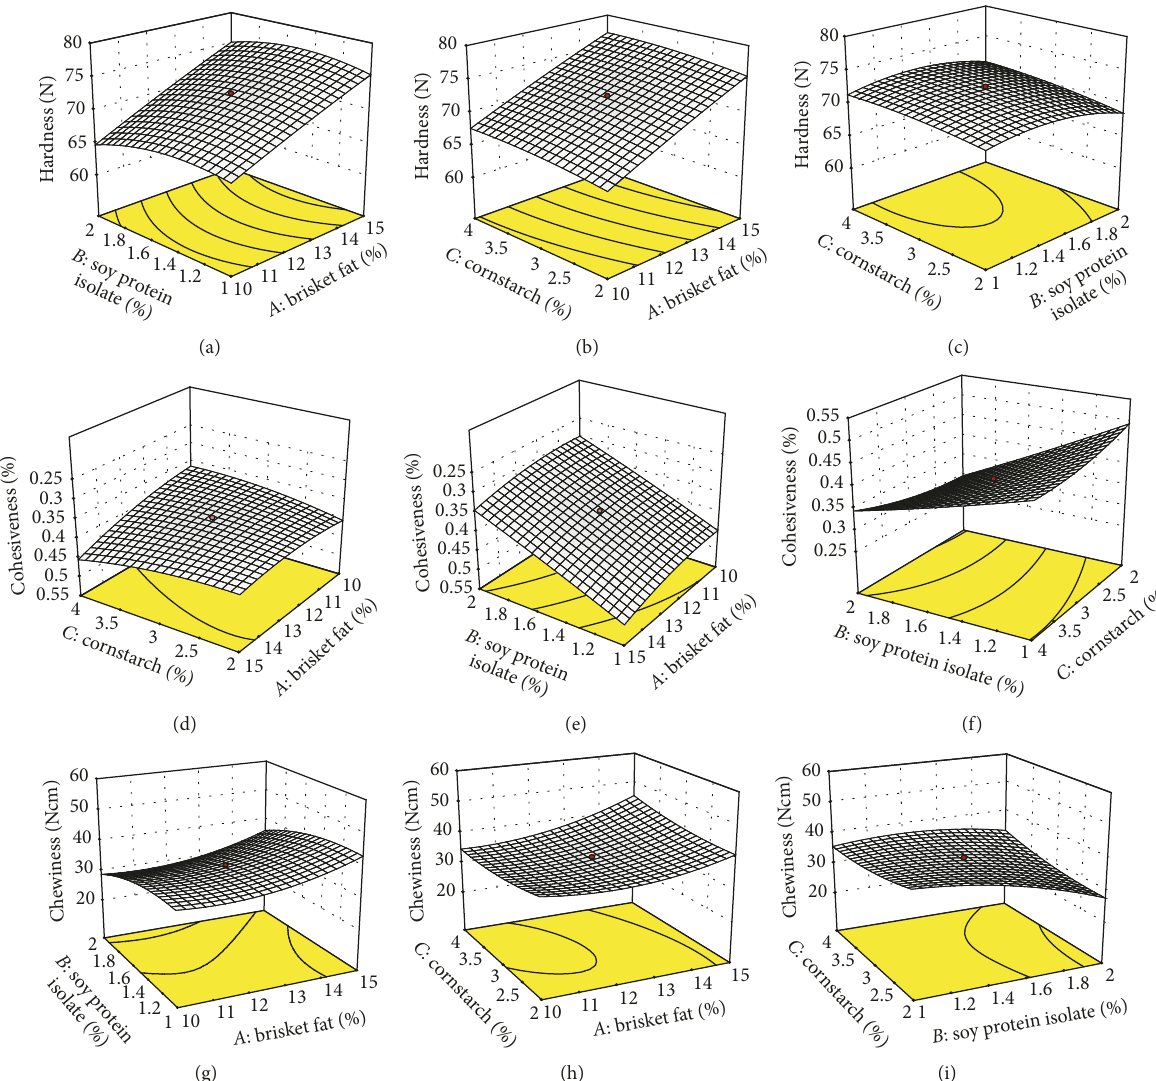
Figure 2: Effect of (a) brisket fat and soy protein isolate, (b) brisket fat and cornstarch, and (c) soy protein isolate and cornstarch on hardness, (d) brisket fat and cornstarch, (e) brisket fat and soy protein isolate, and (f) soy protein isolate and cornstarch on chewiness, and (g) brisket fat and soy protein isolate, (h) brisket fat and cornstarch, and (i) soy protein isolate and cornstarch on cohesiveness along with the second-order polynomial model equations predicting effects of the variables. ((a), (b), (c)) Hardness = 72.22+64.79𝐴−0.53𝐵+0.85𝐶+0.44𝐴𝐵−0.04𝐴𝐶+ 0.27𝐵𝐶 − 0.22𝐴 2 − 1.51𝐵 2 − 0.44𝐶 2 . ((d), (e), (f)) Cohesiveness = 0.38 + 0.023𝐴 − 0.076𝐵 + 1.52 × 10 −3 𝐶 − 9.89 × 10 −4 𝐴𝐵 + 0.022𝐴𝐶 + 0.023𝐵𝐶 + 0.013𝐴 2 + 3.07 × 10 −3 𝐵 2 + 0.012𝐶 2 . ((g), (h), (i)) Chewiness = 35.28 + 3.62𝐴 − 3.57𝐵 + 3.40 × 10 −1 𝐶 + 1.90 × 10 −2 𝐴𝐵 + 1.83𝐴𝐶 + 2.45𝐵𝐶 + 3.07𝐴 2 − 2.38𝐵 2 + 1.36𝐶 2